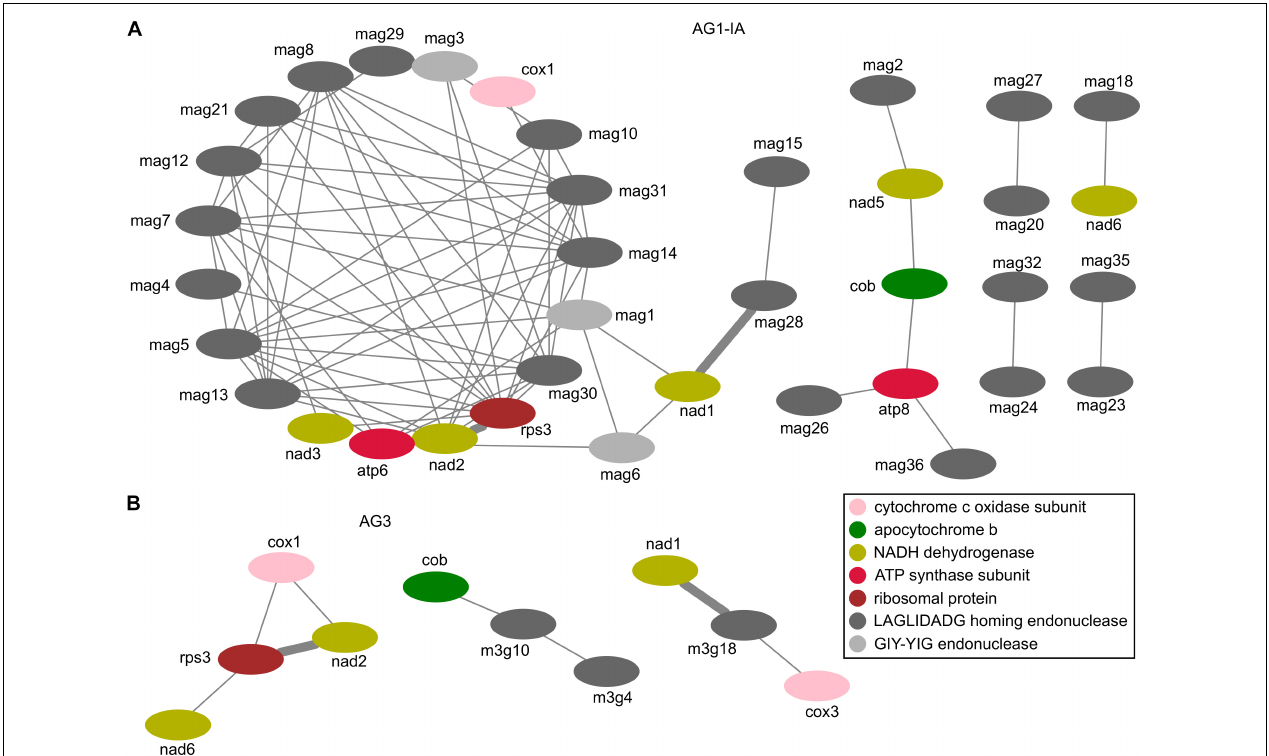
FIGURE 6 | Correlation coefficients between each pair of genes encoded in mitogenomes. (A) The correlations for genes in AG1-IA. (B) The correlations for genes in